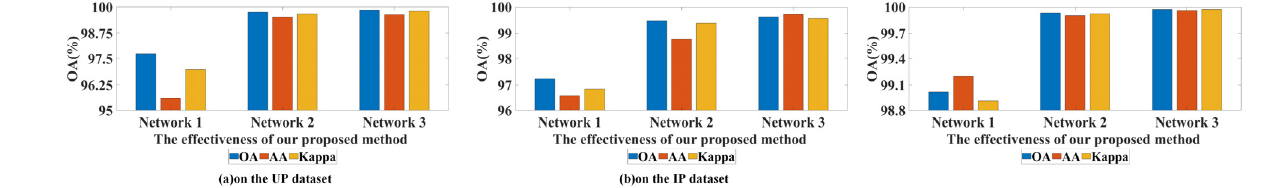
Figure 11. The classification results of ablation study.